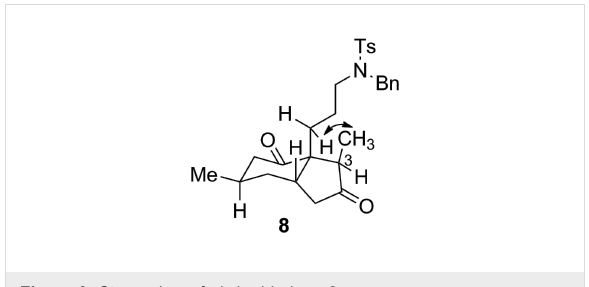
Figure 3: Stereoview of cis -hydrindane 8